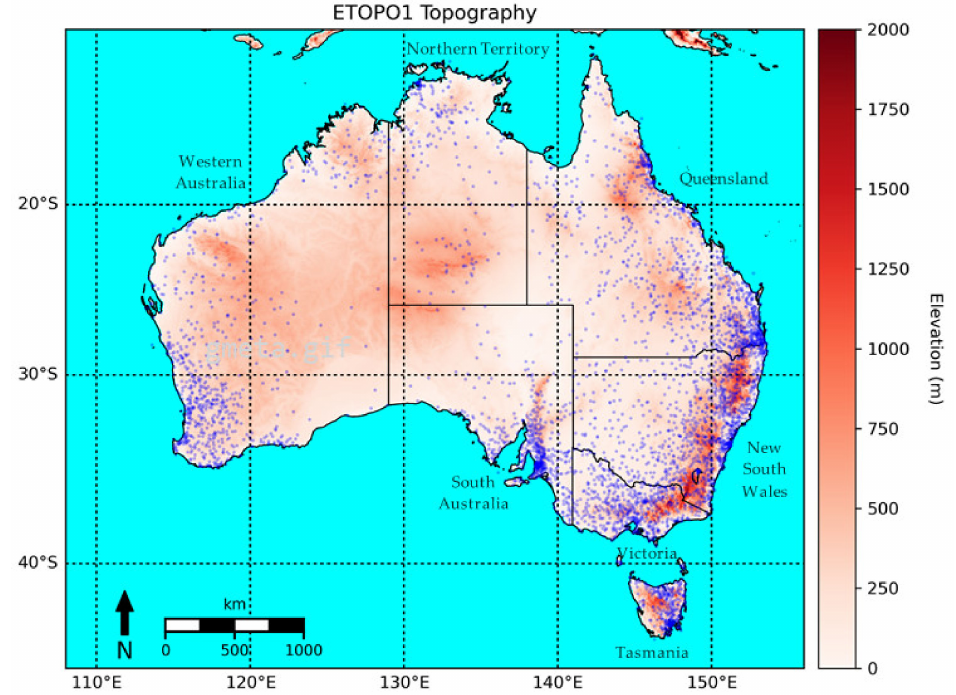
Figure 1. Map of study domain, adapted from [7]. The blue dots represent stations, while the white–red shading depicts elevation as derived from the ETOPO1